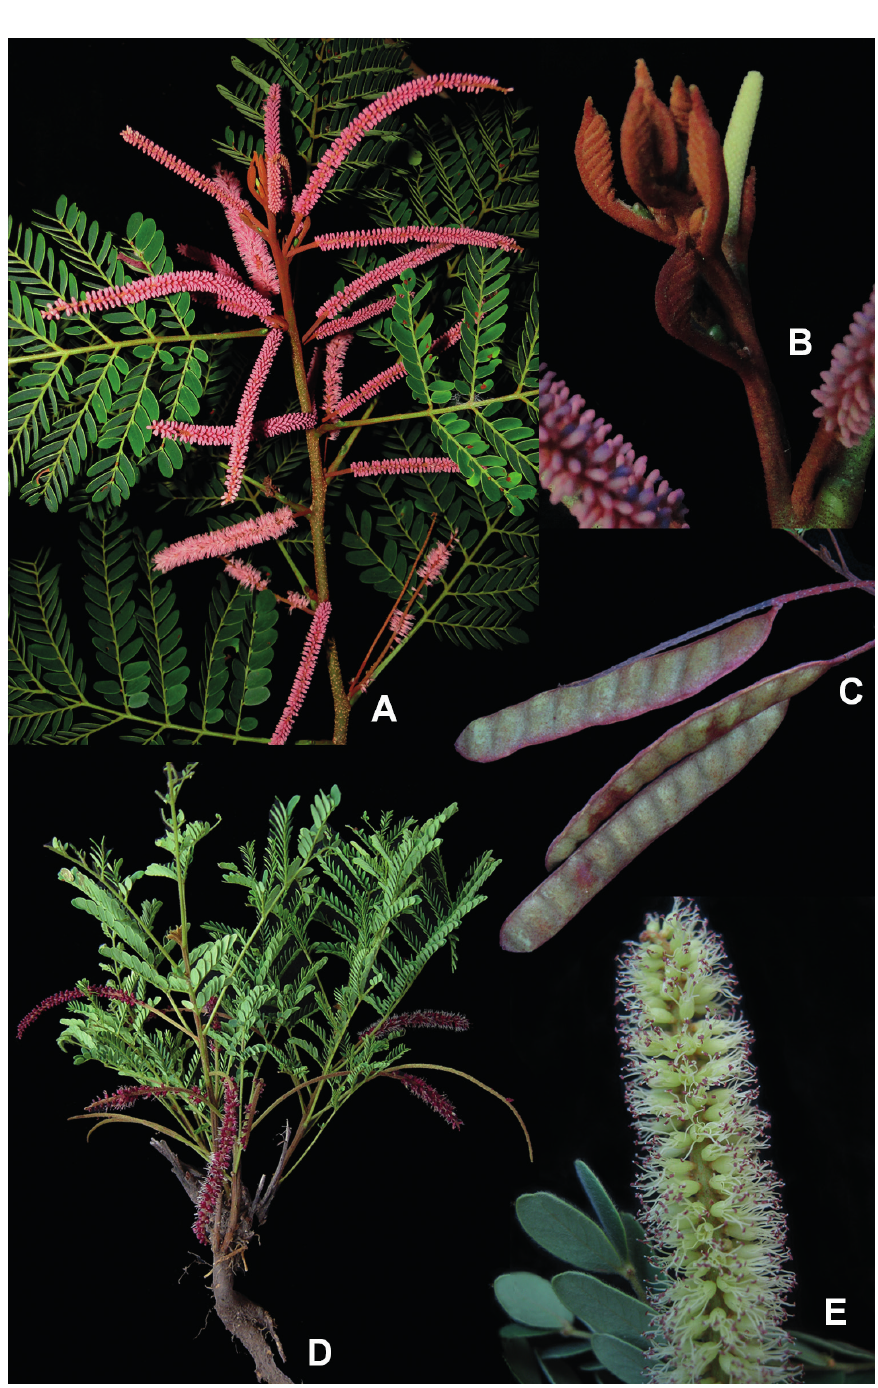
Figure 6. A, B Styphnodendron forreroi : A flowering branch B detail of young shoot covered by reddish granular trichomes C, D S. heringeri : C fruits D habit E S. rotundifolium : detail of inflorescence. Photos: Marcelo